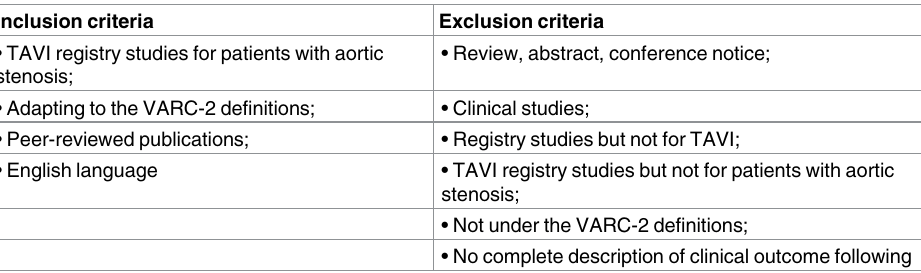
Table 1. Inclusion criteria and exclusion